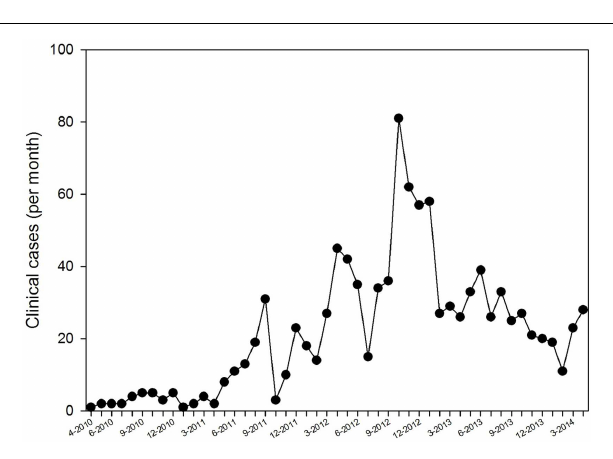
FIGURE 2 | Submission rate of clinical cases ( n = 1067)